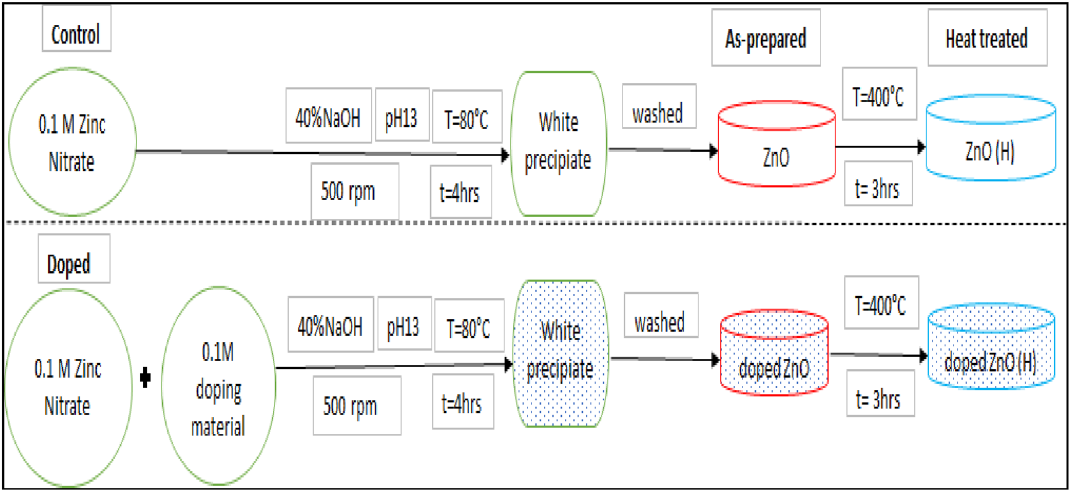
Figure 1. Schematic description of ZnO synthesis and of the doping